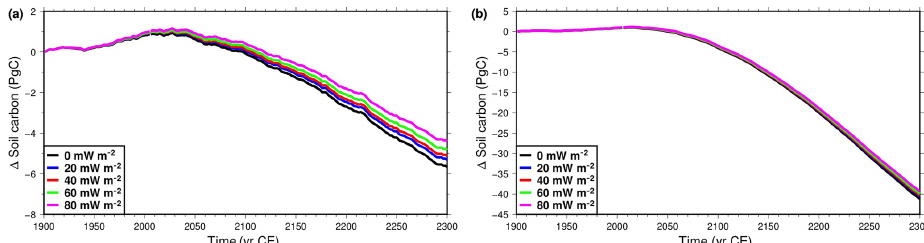
Figure 13. Evolution of soil carbon pool in the Northern Hemisphere permafrost region, compared to the size for the original model at 1901CE. Models with varying basal heat flux. (a) Simulations forced with CRUNCEP+RCP4.5 data. (b) Simulations forced with CRUN- CEP+RCP8.5 data. Note the vertical scale difference between the two